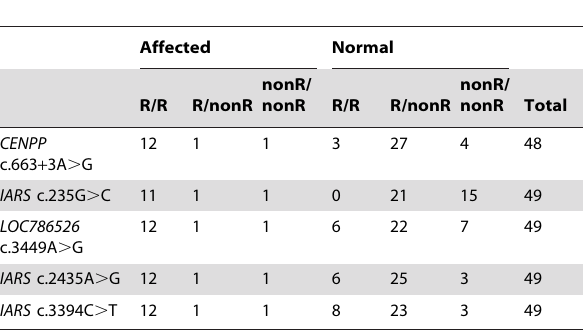
Table 1. Confirmation of 3 SNPs in CENPP , IARS and LOC786526.